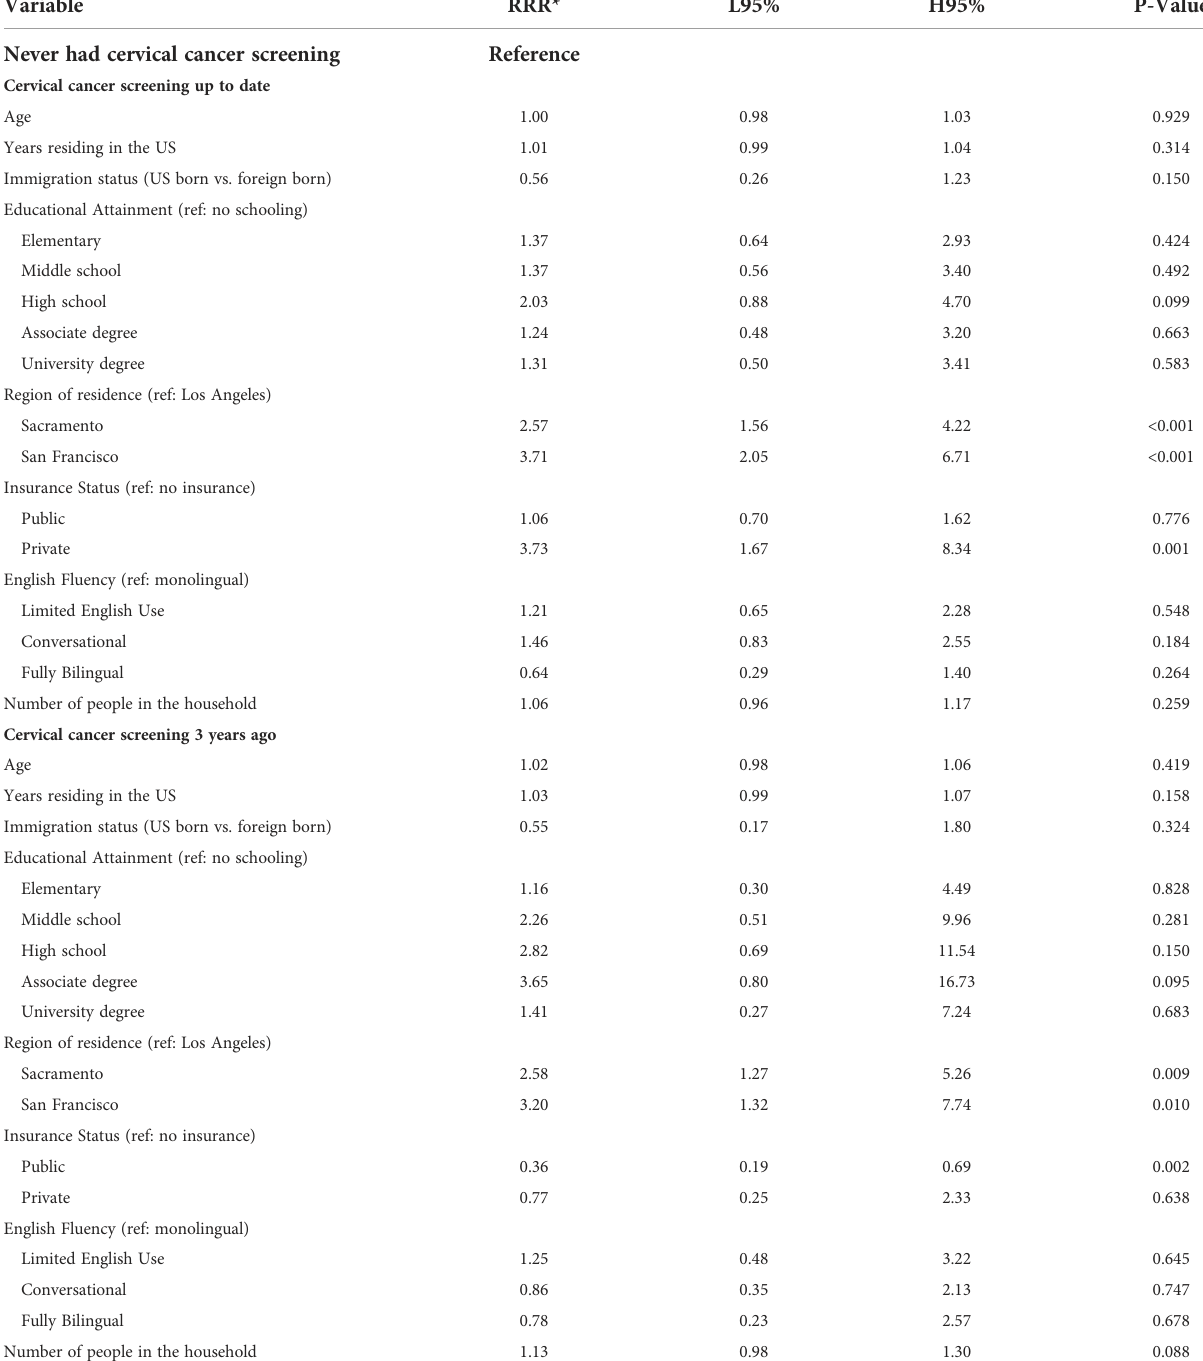
TABLE 5 Multivariate multinomial logistic regression model testing the association between cervical cancer screening behavior and demographic factors among ‘ Tu Historia Cuenta ’ participants ages 21 to 65 (N=932, 80 excluded from 1012 due to missing data). Variable RRR* L95% H95% P-Value